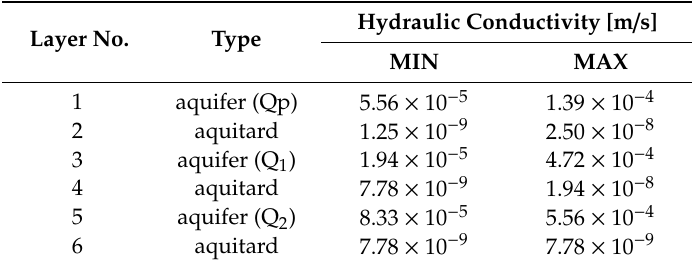
Table 2. Values of hydraulic conductivity and specific yield assigned for each layer of the model. Layer